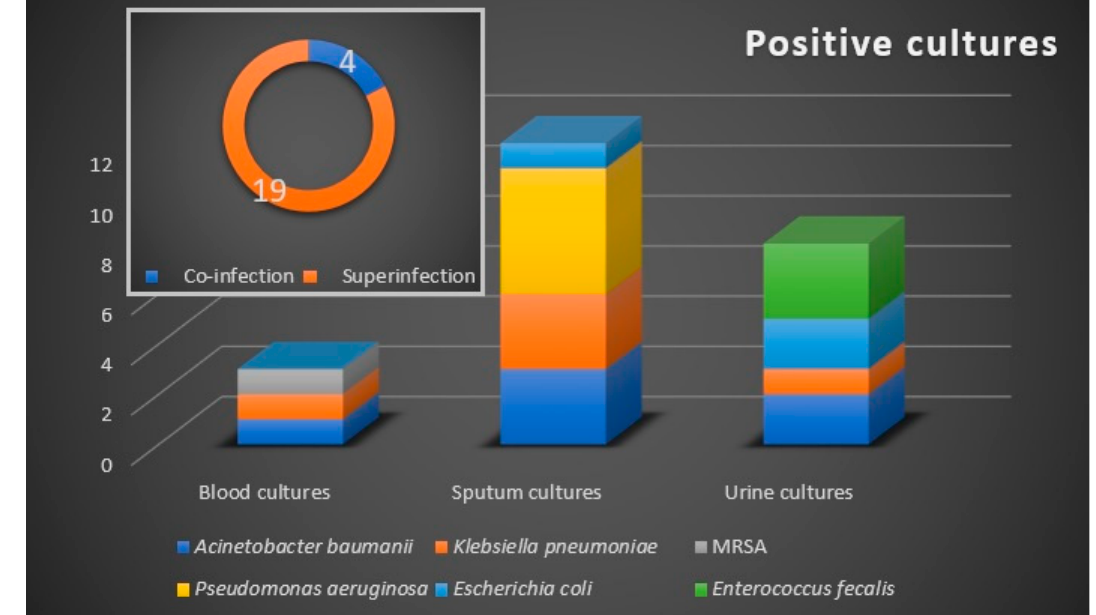
Figure 1. Bacteriological profile with the distribution of co-infections and superinfections. Microbi- ological samples are blood, sputum, and urine. Etiologic agents are marked by color and they are allocated according to the confirmed microbiological sample.